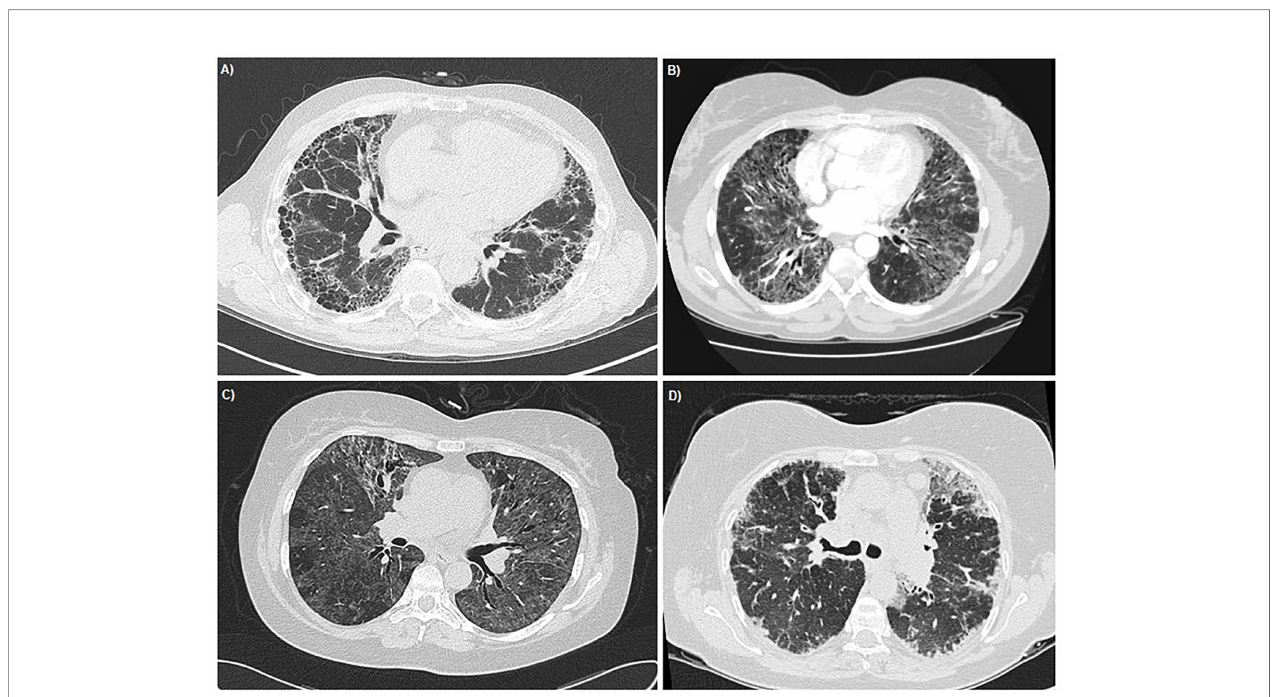
FIGURE 1 | Thoracic HRCT images demonstrating the radiological appearances of the four sub-types of TIP. (A) Pulmonary Fibrosis - Case courtesy of Dr Ian Bickle, Radiopaedia.org, rID: 26493 (B) Acute Diffuse Interstitial Pneumonia - Case courtesy of Radswiki, Radiopaedia.org, rID: 11516 (C) Sub-acute Diffuse Interstitial Pneumonia - Case courtesy of Dr Mark Holland, Radiopaedia.org, rID: 19551 (D) Pulmonary Opacities with peripheral eosinophillia - Case courtesy of Dr Lawrence Josey, Radiopaedia.org, rID: